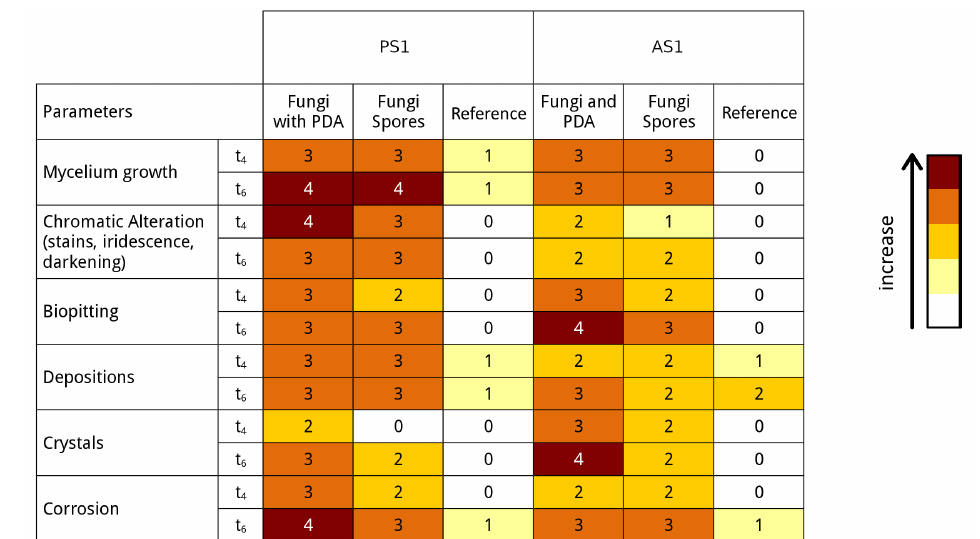
Figure 6. Summary of the damages observed in all samples after 4 and 6 months incubation– comparative analysis. Average damage is classified into a semi-quantitative scale from 0 to 4 (from non-existent to very pronounced, considering parameters such as density, quantity, and dimensions). A chromatic scale is used for better visualisation of the